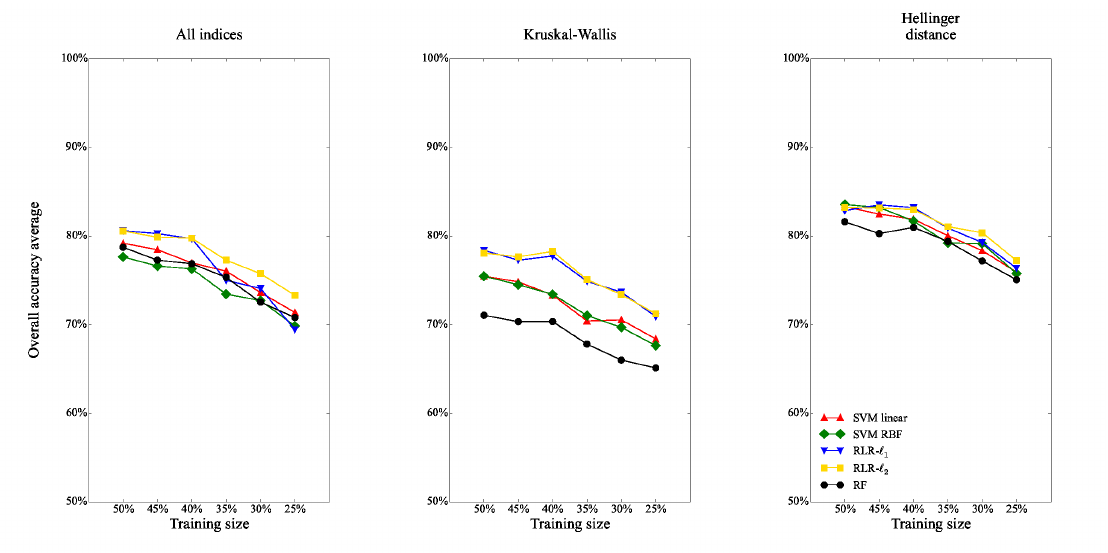
Figure 14. Vegetation types identification accuracies (overall accuracy) with indices. Table 15. Confusion matrix of the classification based on Regularized Logistic Regression (RLR)- (cid:96) 2 with all indices and training size = 25%. The producer’s and user’s accuracies and the overall accuracy average (OAA) are also